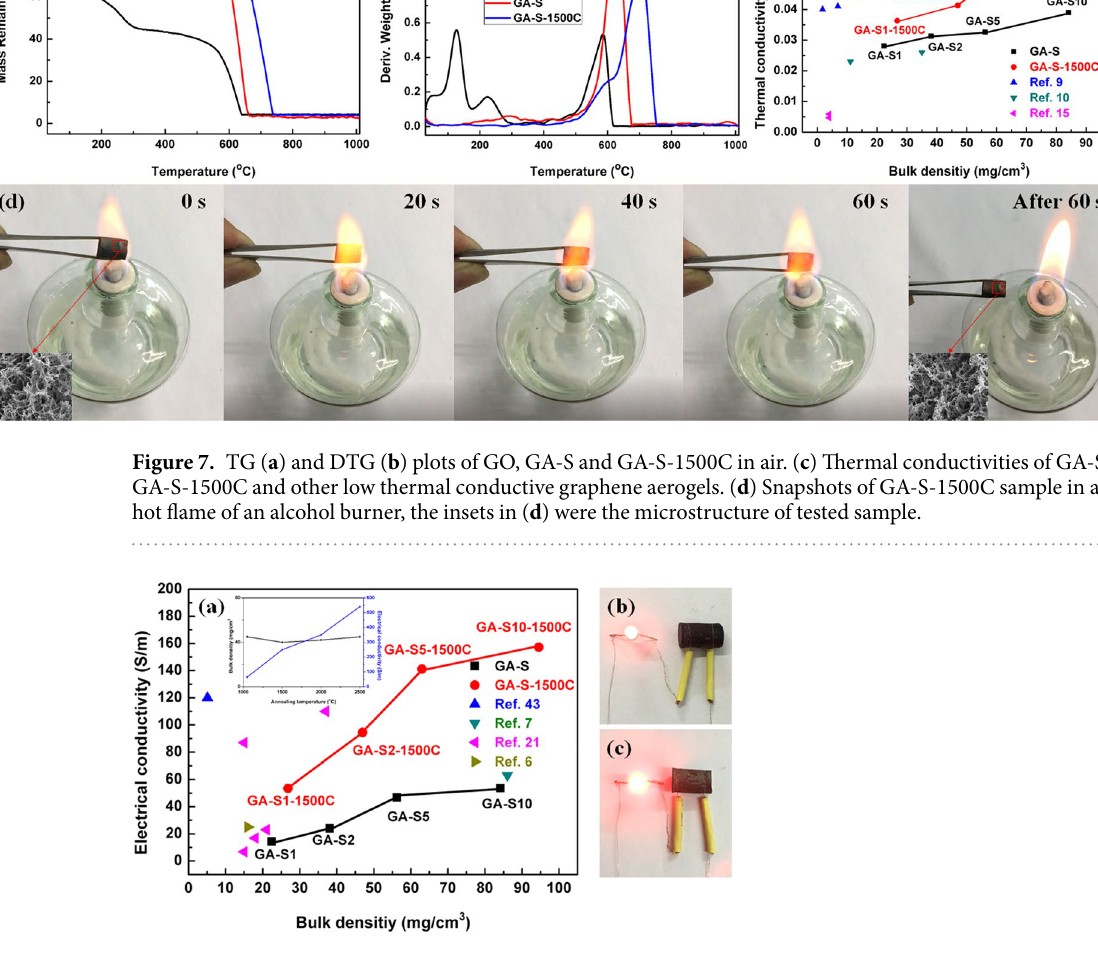
Figure 8. Electrical conductivities ( a ) of GA-S, GA-S-1500C and other high electric conductive graphene aerogels, the inset in ( a ) was the bulk density and electrical conductivity of graphene aerogels vs annealing temperature in ref. 22. A circuit constructed with the GA-S ( b ), GA-S-1500C ( c ) cylindrical